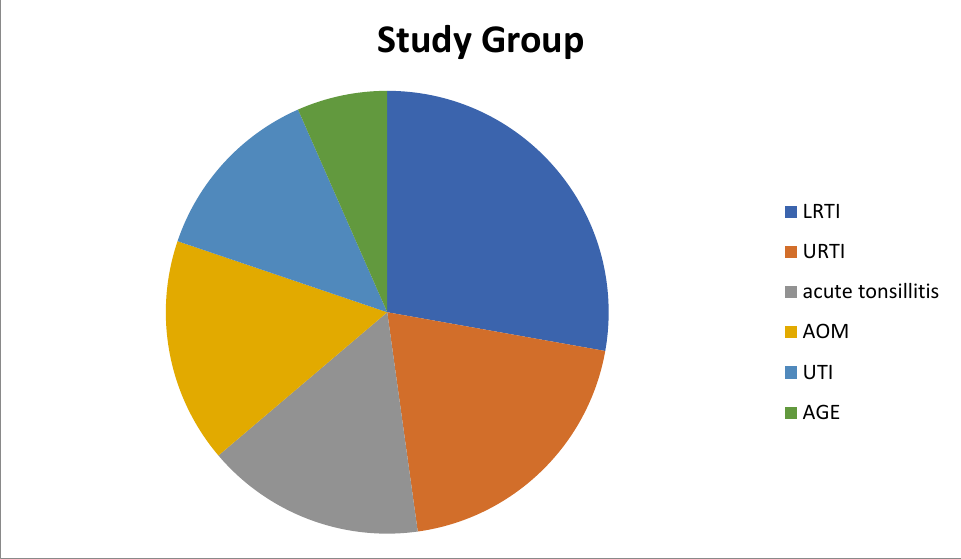
Figure 1. Diagnoses of patients in the study group that cause fever. LRTI: Lower Respiratory Tract Infection, URTI: Upper Respiratory Tract Infection, AOM: Acute Otitis Media, UTI: Urinary Tract Infection, AGE: Acute Gastroenteritis.